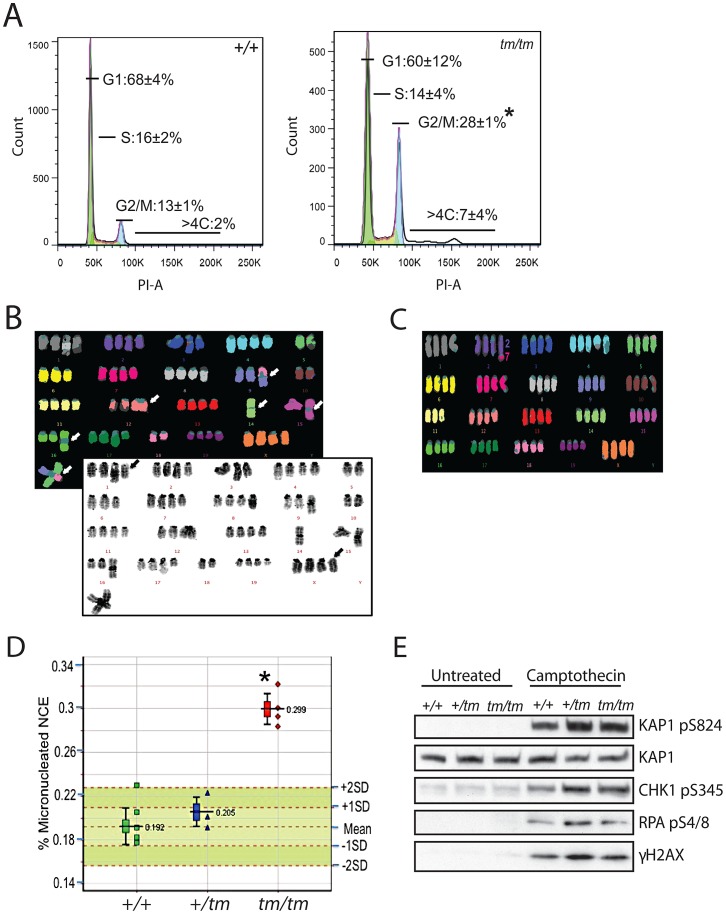
Genomic instability is associated with abnormal ploidy of Cenpjtm/tm cells rather than an impaired DNA damage response.A. Cell cycle analysis of Cenpjtm/tm mouse embryonic fibroblasts (MEFs) by flow cytometry showed an increase in the percentage of cells in G2 (4C) and cells containing >4C DNA content when compared to Cenpj
+/+ cells. Percentages represent means of n = 3 independent MEF lines per genotype (each pair of +/+ and tm/tm cells were passage-matched (passage<5) and derived from littermates), *P<0.05, t-test. PI, propidium iodide. B. Example multiplex fluorescent in situ hybridization (M-FISH; top) and DAPI banded (bottom) karyotype of a Cenpjtm/tm MEF metaphase (passage 4). The karyotype is near tetraploid, with centric fusions (white arrows) and chromosomes that have apparently lost their centromeres (black arrows). C. Example M-FISH of a Cenpjtm/tm MEF metaphase (passage 4) showing near tetraploid karyotype with a translocation (t(2;7)). D. Adult Cenpjtm/tm (n = 4) mice showed increased genomic instability when compared to Cenpj
+/+ mice (n = 6) as determined by the increased prevalence of micronucleated normochromatic erythrocytes using a flow cytometric assay of micronucleus formation. *P = 0.000004, t-test. The lower whisker extends to the lowest datum still within 1.5 Inter-quartile range (IQR) of the lower quartile. The upper whisker extends to the highest datum still within 1.5 IQR of the upper quartile. E. Immunoblots show normal activation of DNA damage response markers in Cenpj-deficient MEFs (passage 2) before and after treatment with the DNA damaging agent camptothecin (1 µM for 1 h). KAP1 was used as a loading control.